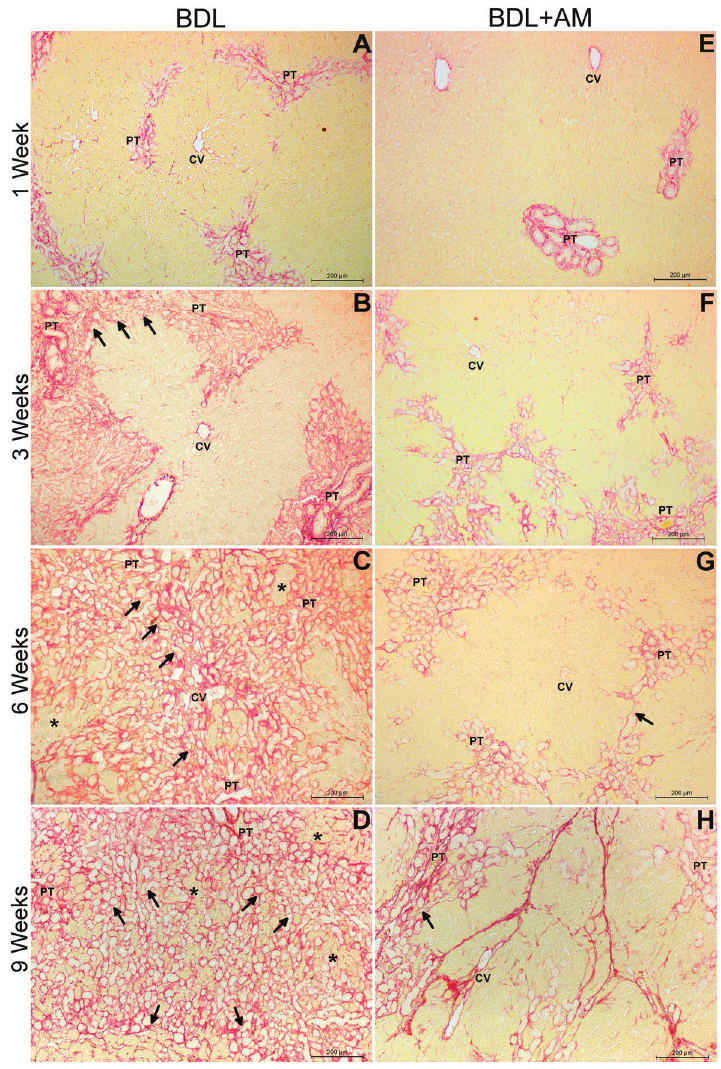
Figure 5. Representative microphotographs of liver fi brosis progression in the experimental groups BDL (A – D) and BDL + AM (E – H), at 1, 3, 6, and 9 weeks after fi brosis induction. BDL: bile duct ligation; AM: amniotic membrane; CV: central vein; PT: portal tract with ductular expan- sion; arrows: connection ( fi brotic septa) between the expanded portal tracts; *: nodules of hepato- cytes. Sirius Red staining with a magni fi cation of 100 (cid:1)